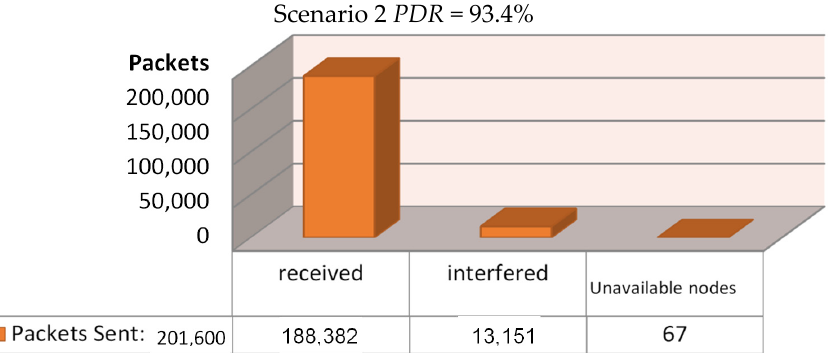
Figure 10. Scenario 2—Regarding the setup’s effectiveness once installing the gateway at the roof of the building.